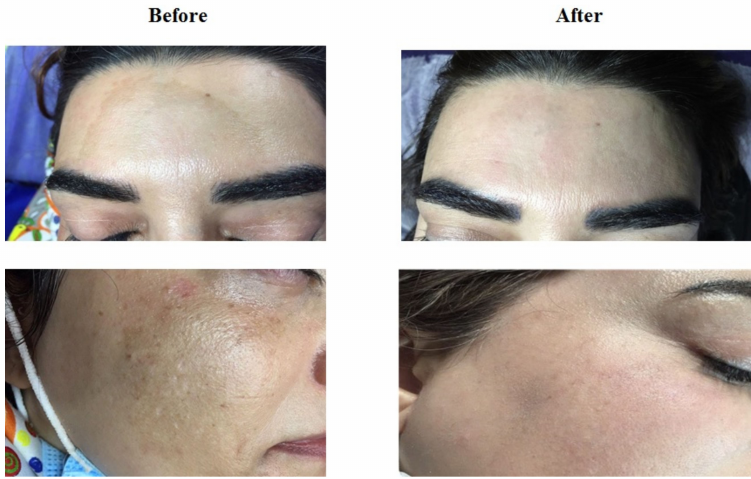
Figure 1. Response before and after treatment with the fractional CO 2 laser.